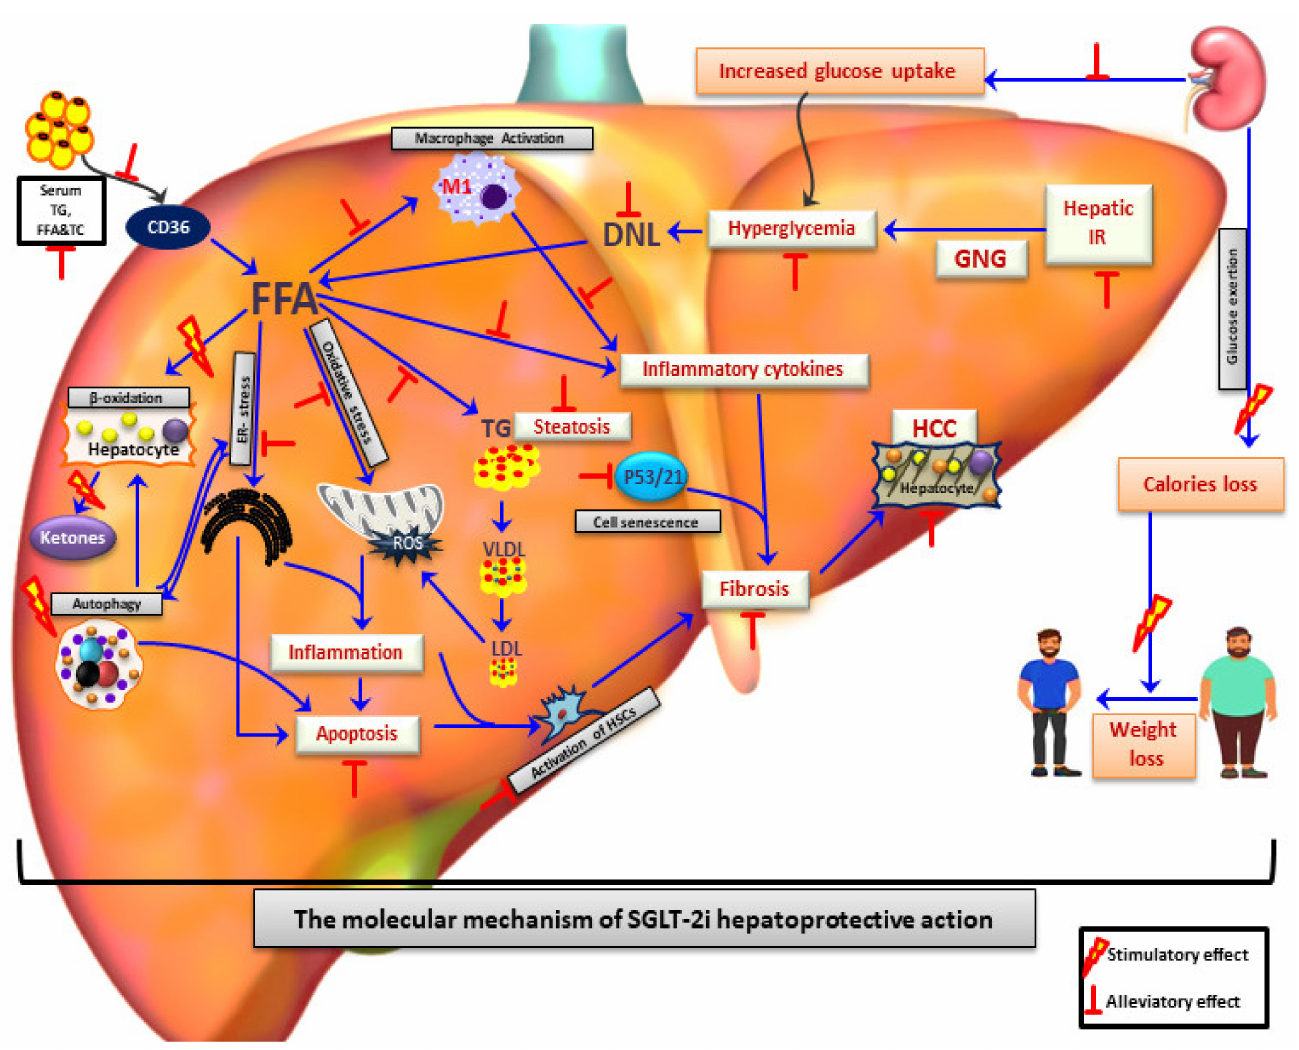
Figure 1. SGLT-2 inhibitors as a promising therapeutic agents for treatment of NAFLD/NASH patients. SGLT-2i treatment contributes to alleviation of NAFLD by reduction of hyperglycaemia, improvement of systematic insulin resistance, elevation of caloric loss and reduction of body weight mostly due to glycosuria. Apart from that, SGLT-2i play a hepatoprotective effect through reduction of hepatic de novo lipogenesis, hepatic inflammation, apoptosis, ER-stress, oxidative stress, and increase of hepatic beta-oxidation. Reduced activation of hepatic satellite cells and p53/p21 pathways by SGLT-2i leads to amelioration of hepatic fibrosis and HCC development. FFA: Free fatty